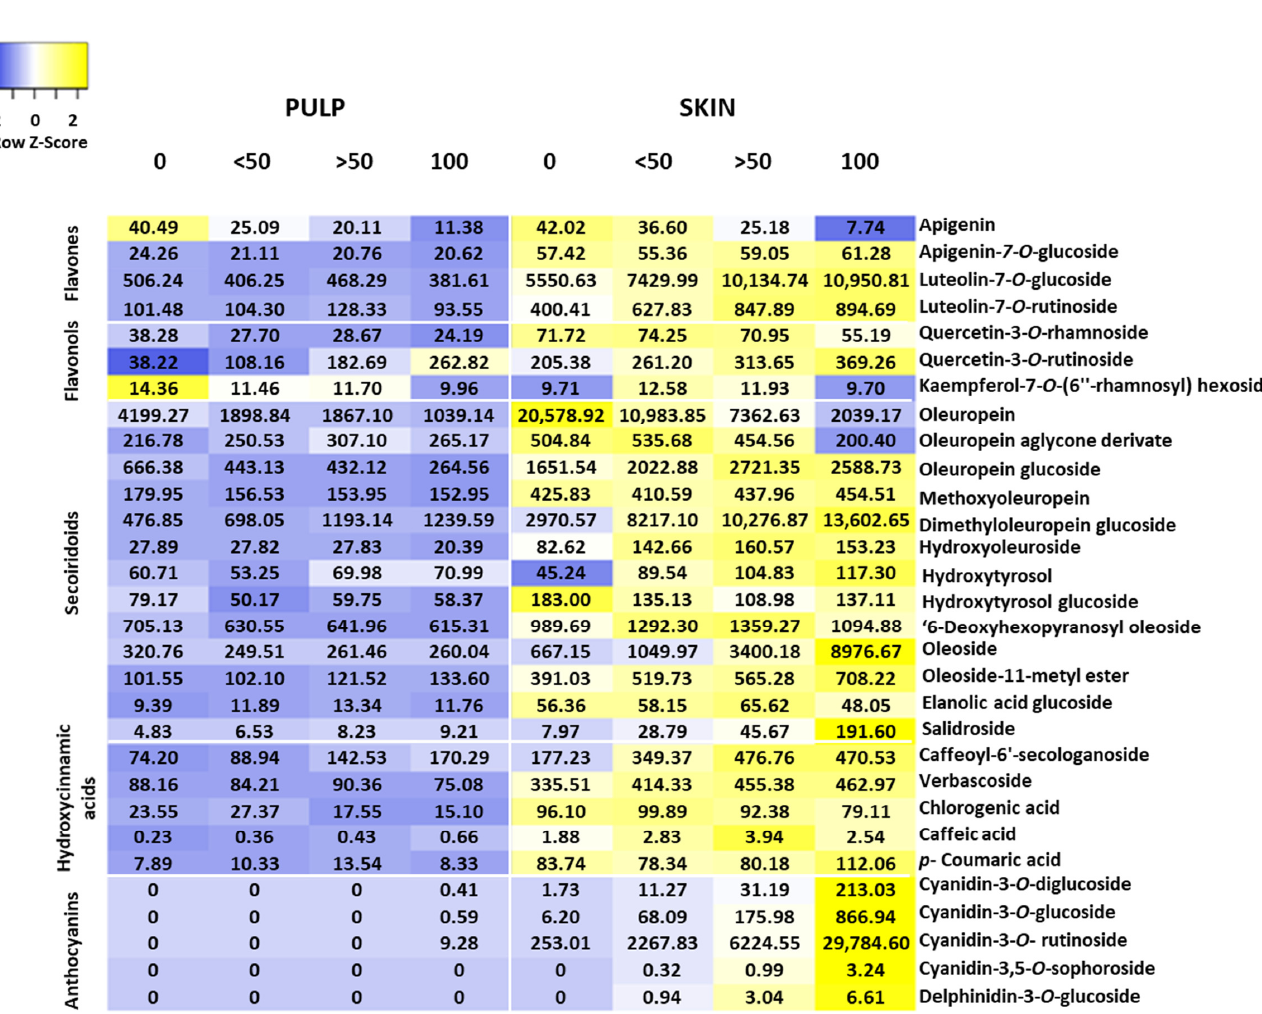
Figure 3. Heatmap with means of phenolic compounds present in olive fruits in the skin and pulp during ripening. Data are means of four replicates. phenolic compounds are calculated using their standards.